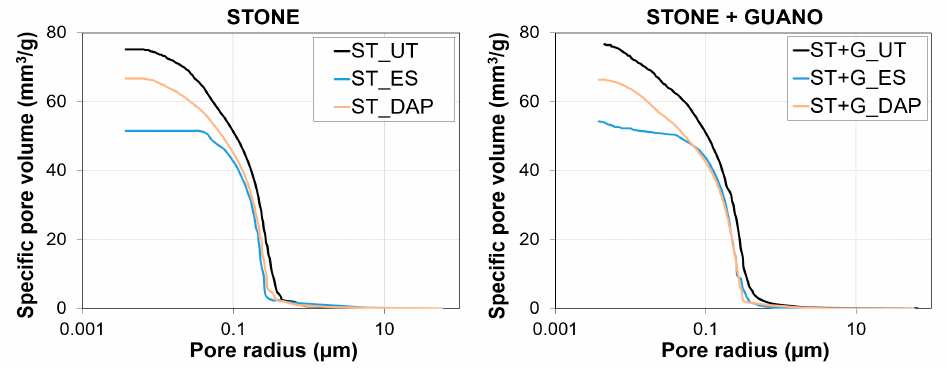
Figure 11. Pore size distributions of untreated (“UT”) and treated (“ES” and “DAP”) specimens of stone (“ST”) and stone+guano (“ST+G”).